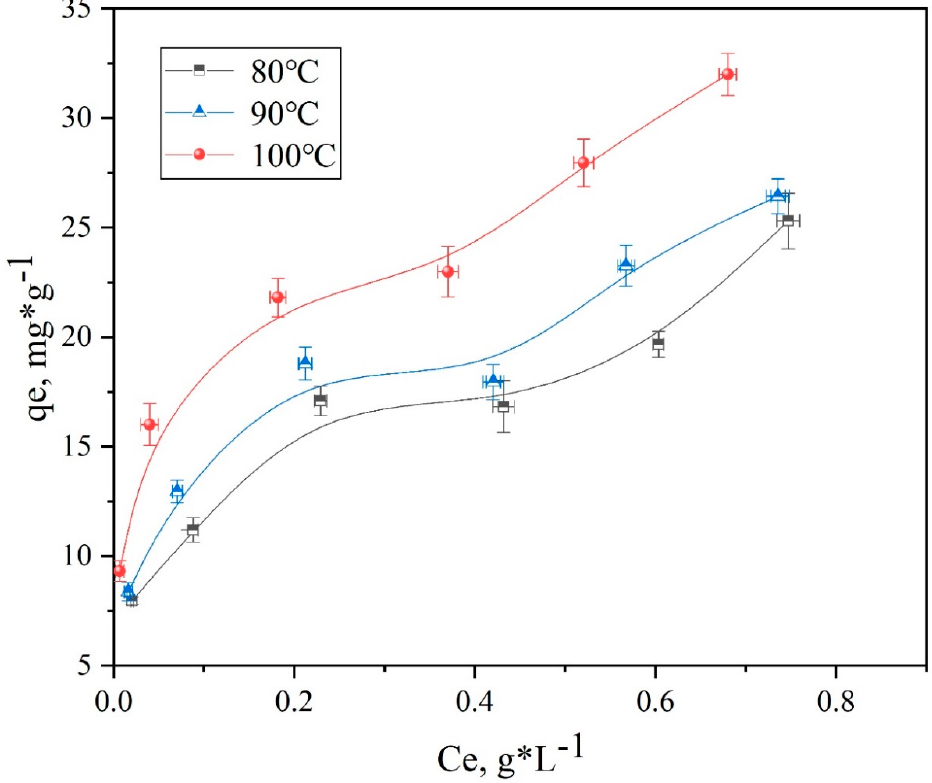
Figure 12. Adsorption isotherms of ordinary spandex dyed with neutral red G.